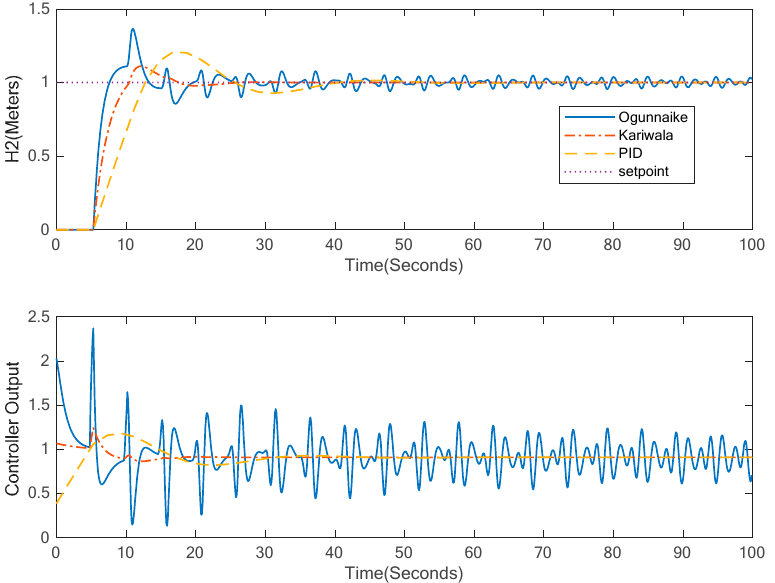
Figure 11. Example 1: Servo response with the RTD-A controller using optimization algorithms.